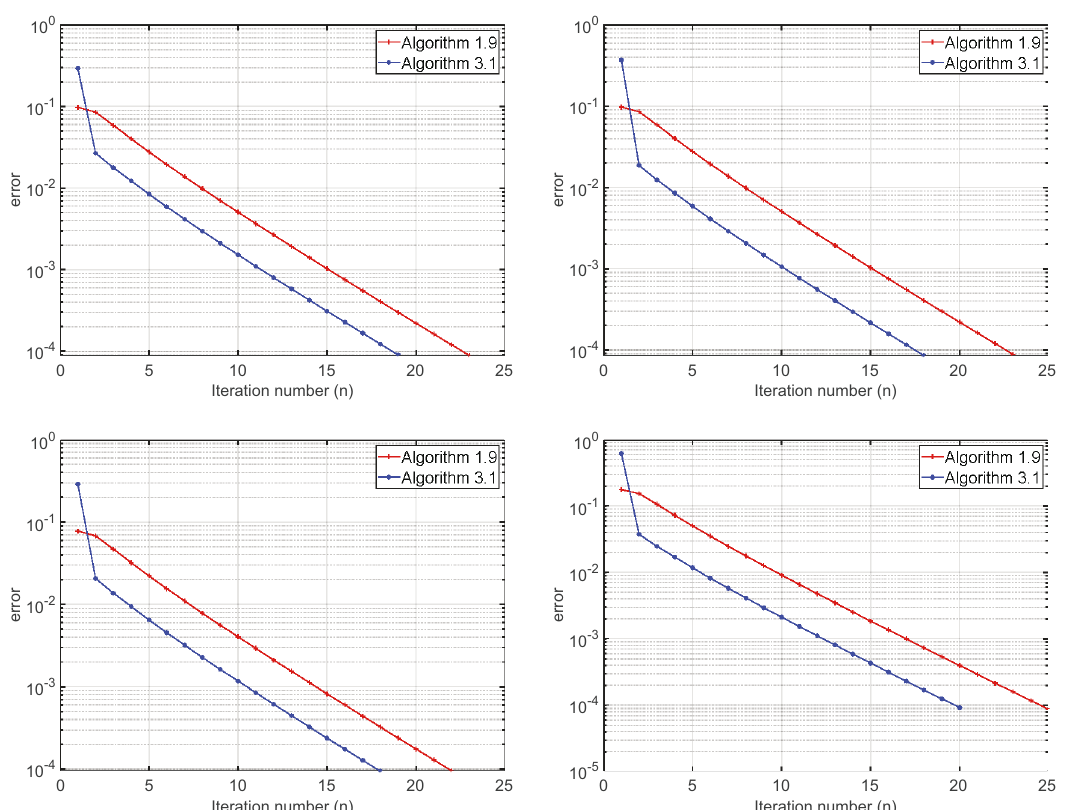
Algorithm 1.9 Algorithm 3.1